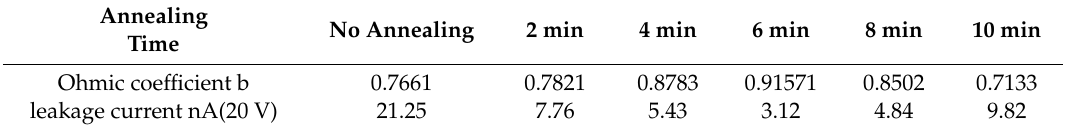
Table 5. The I–V curves fitting results of Ti-Au / CdZnTe annealed at 423 K for di ff erent times.